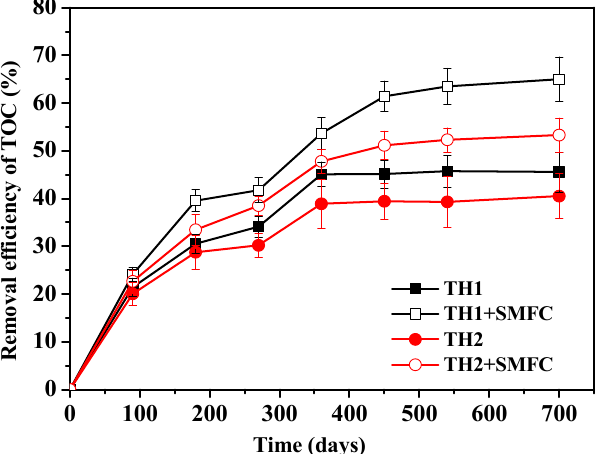
Figure 3. Removal e ffi ciencies of total organic carbon (TOC) in TH1 and TH2 sediments by control and Figure 3. Removal efficiencies of total organic carbon (TOC) in TH1 and TH2 sediments by control SMFCs during the 700 days of and SMFCs during the 700 days of incubation.